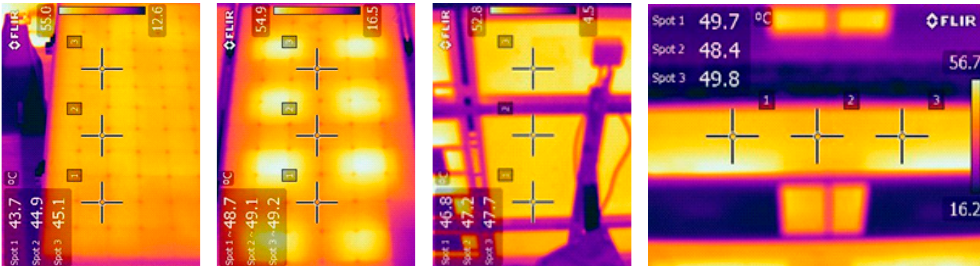
Figure 5. Thermal ( left ) and visual ( right ) images of the PV modules with and without the battery storage system for ambient conditions T a ≅ 8 °C and G n ≅ 600 W/m 2 .